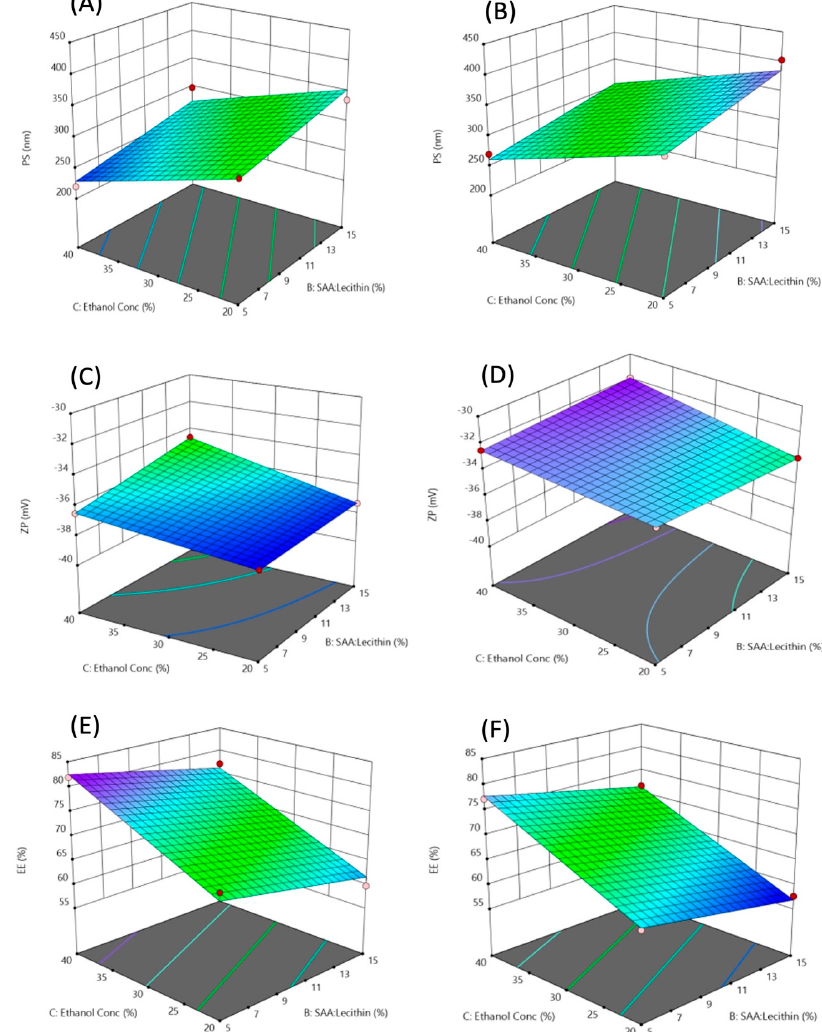
Figure 1. 3D-response surface plots showing the effect of the independent variables on PS ( A , B ), ZP ( C , D ), and EE% ( E , F ). ( A , C , E ) where the used SAA is Labrafil, ( B , D , F ) where the used SAA is SDC . Table 3. Observed responses for the prepared TEs formulations.